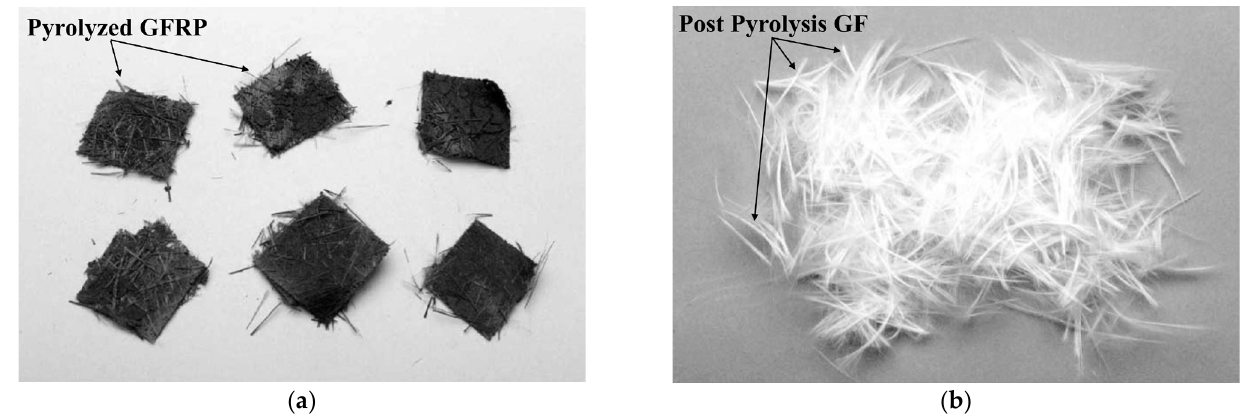
Figure 8. Example of pyrolyzed material before ( a ) and after ( b ) the post-pyrolysis process